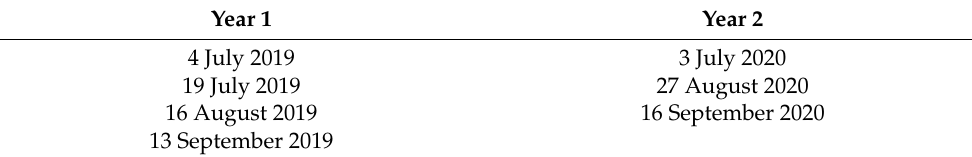
Table 3. Image acquisition dates during the study period.